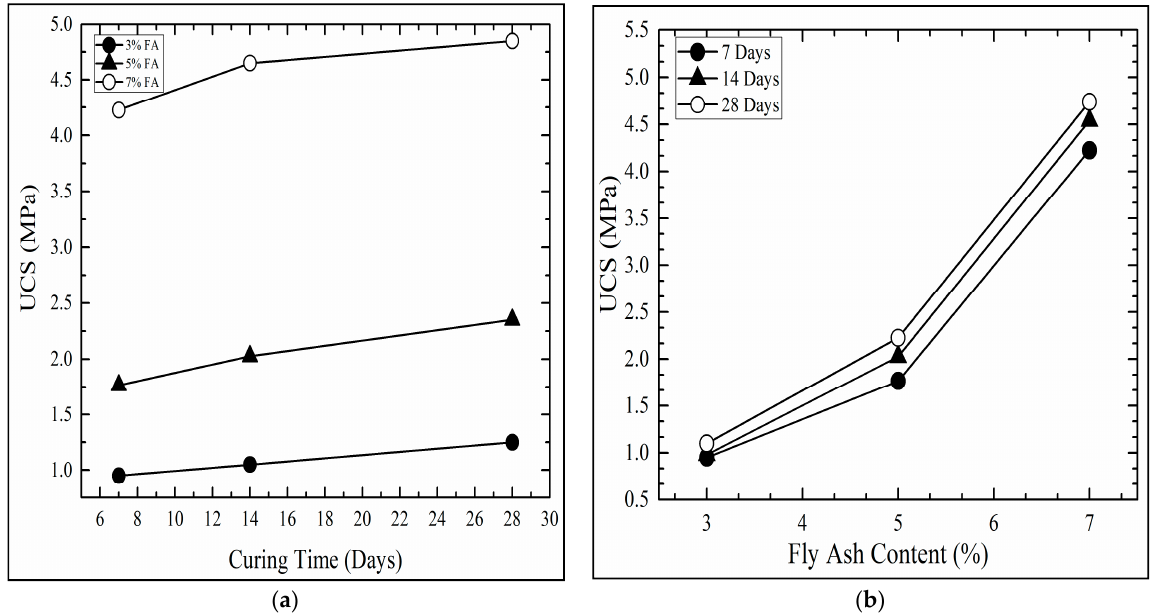
Figure 6. Effect of FA on the UCS and different curing time (7, 14, and 28 days) for the 30:70 treat mixtures.